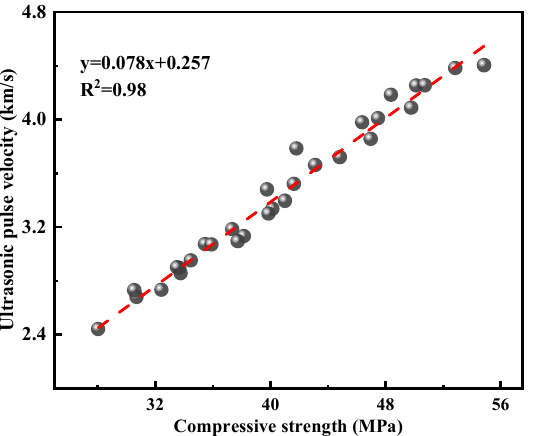
Figure 7. The relationship between the elasticity modulus and compressive strength.